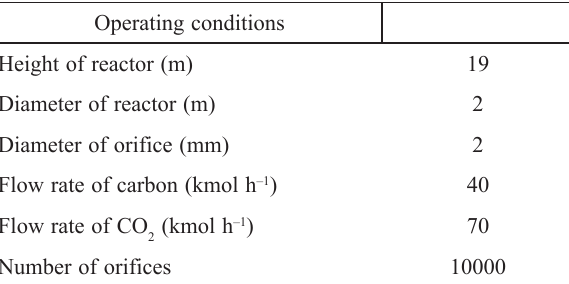
Table 3 – Base case operating conditions for sensitivity